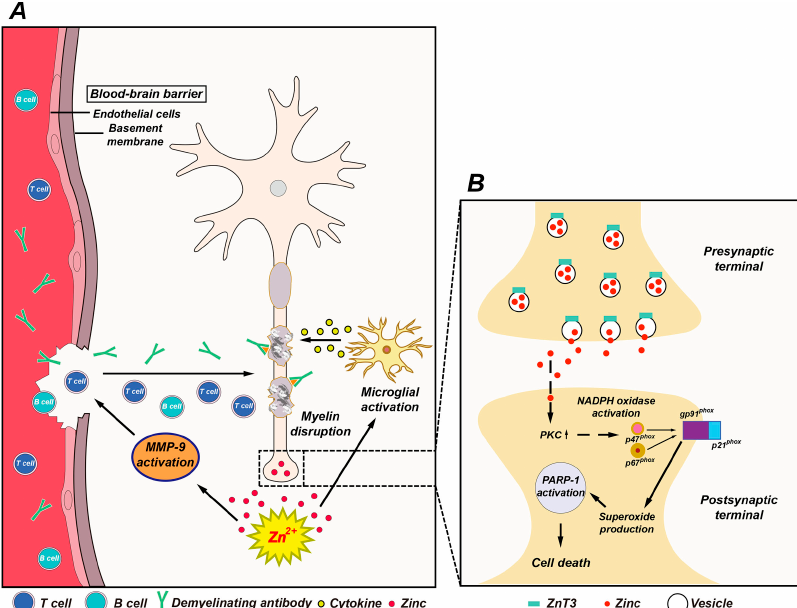
Figure 1. Possible association of zinc with multiple sclerosis (MS) pathogenesis. ( A ) This schematic drawing indicates several ways in which zinc may influence MS pathogenesis. Released zinc